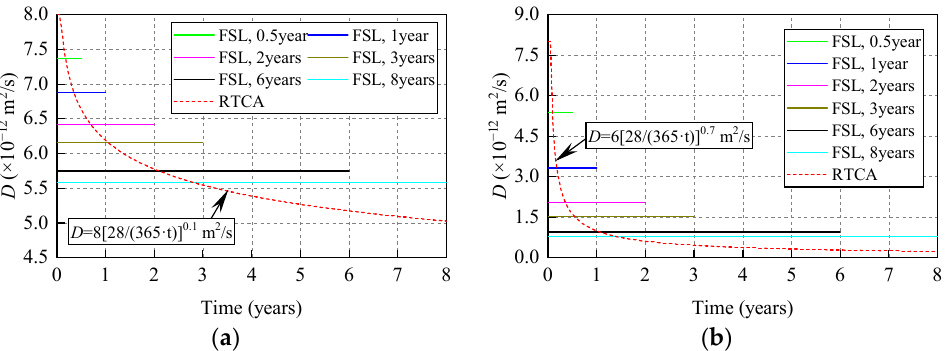
Figure 10. Variations of the diffusion coefficient with corrosion time in the two calculation methods: ( a ) PC concrete; ( b ) fly ash concrete.